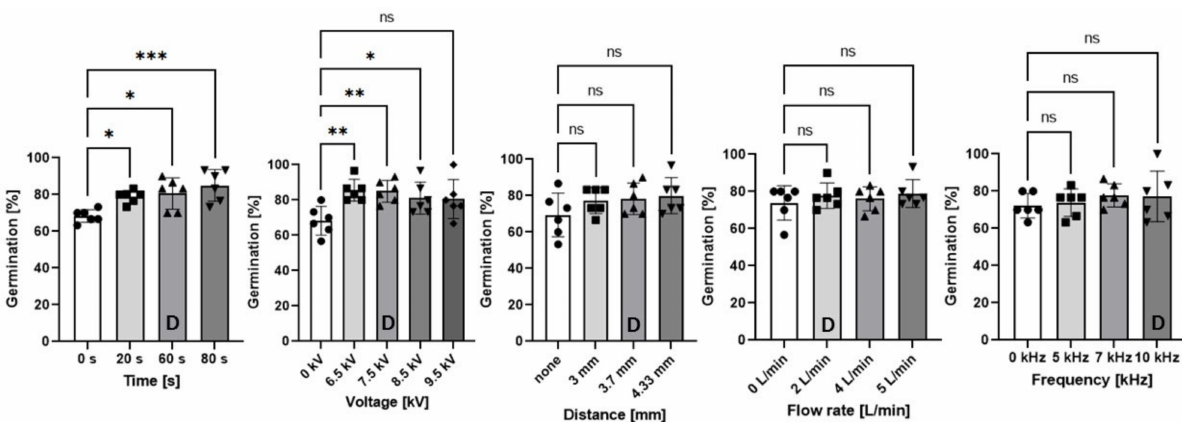
Figure 1. Germination rate results of plasma-treated Arabidopsis seeds from the parametric study. Germination was measured at 48 h with seeds grown on water agar in continuous light conditions at 23 ◦ C with 65% RH. Experiments are an average of triplicates performed twice independently, for a total of 6 replicates. Asterisks denote statistical significance where * signifies p < 0.05; ** is p < 0.01; and *** is p < 0.001. The “ns” indicates “not significant”. The label “D” in each graph denotes the default parameter